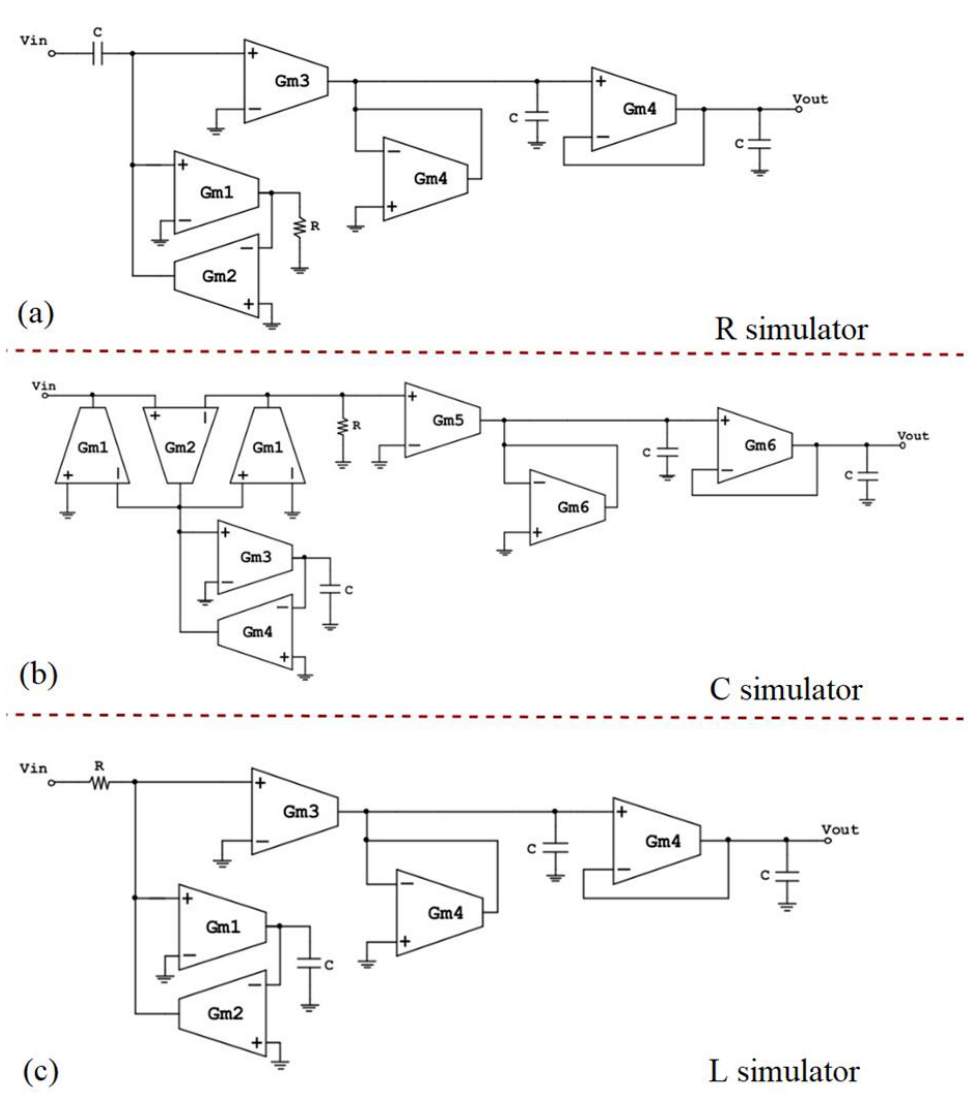
Figure 9. OTA-based passive element replacement bandpass filters—cascaded topologies ( a ) R simulator, ( b ) C simulator, ( c ) L simulator.